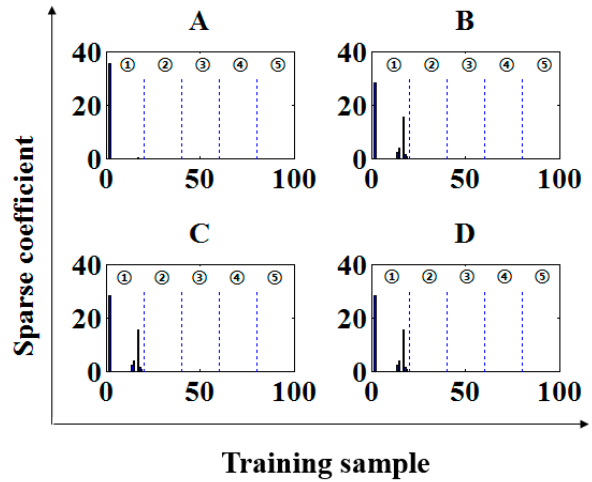
Figure 2. Sparse solutions under different fault tolerances. (There are a total of five classes of training data, each containing 20 samples of infrared spectral data separated by dashed lines; the numbers above the interval represent different classes; e.g., ① denotes the first class; A, B, C, and D stand for the sparse coefficient distributions under different fault tolerances; this figure shows one specific prediction sample that belongs to the first class.)